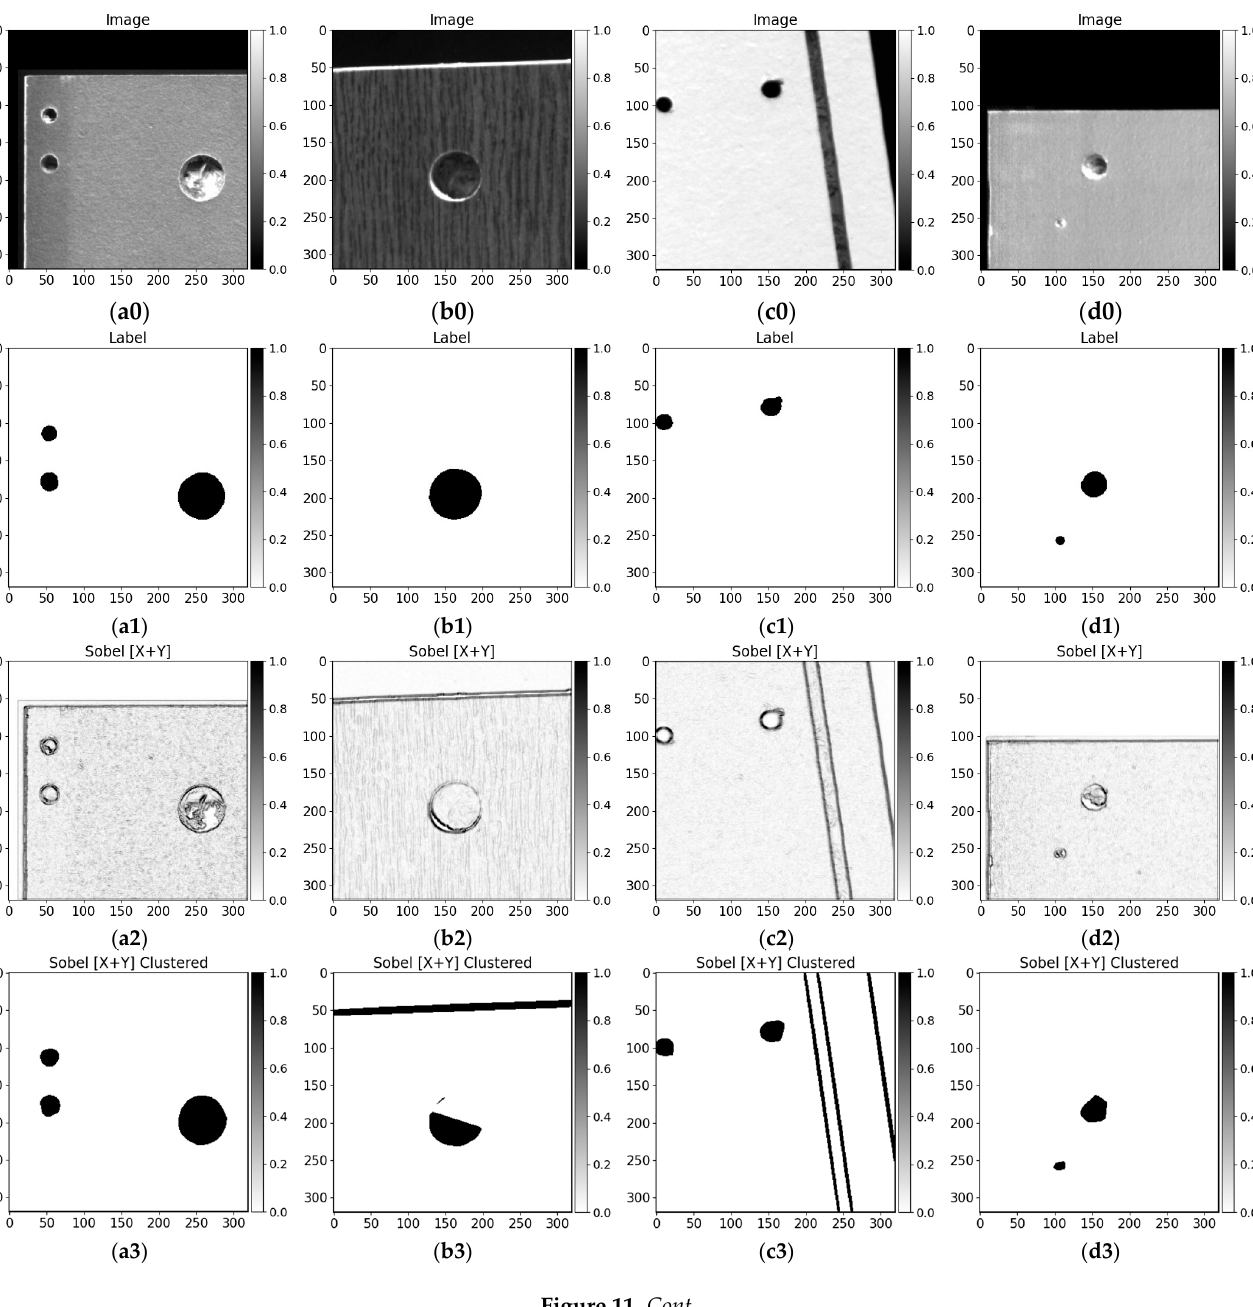
Table 3. Image processing methods performance results.